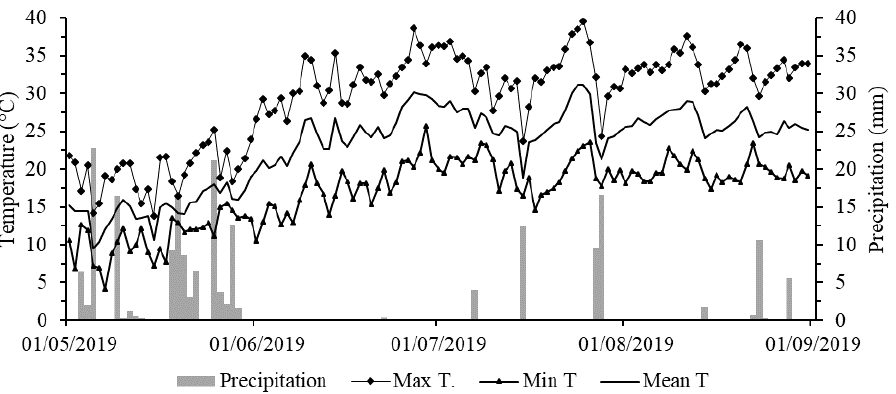
Figure 2. Average, maximum and minimum temperatures (°C), and precipitation (mm) observed during the growing season (May – August